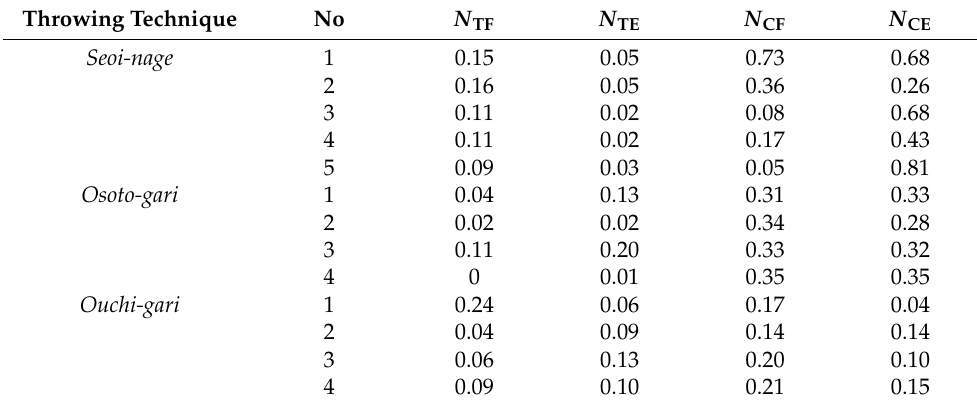
Table 1. Results of the neck injury criterion N ij by throwing techniques.